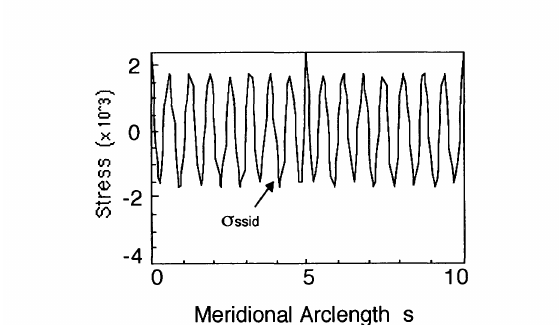
FIGURE 6 Distribution of stress component for exci tation frequency f = 500 Hz, a little above the ring extensional frequency (fE = 438 Hz). This is the same shell as in Fig. l(c), (steel, Rtf = 200, LlR = 10, clamped ends), but for the harmonic of circumferential variation in the ring load n = 2. The significant wave length is the same order as the static decay distance in Fig. l(c) for this and the many modes with frequen cies near fE'